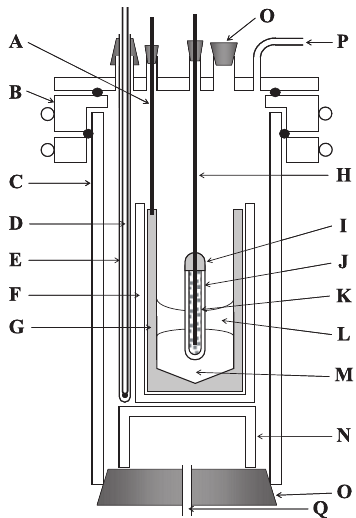
Fig. 1: Schematic diagram of the experimental apparatus. (A) iron rod, (B) water-cooled brass flange, (C) mullite reaction tube, (D) Pt-PtRh13 thermocouple, (E) alumina sheath, (F) alumina crucible, (G) iron crucible, (H) molybdenum rod, (I) zirconia cement, (J) ZrO (MgO) solid electrolyte tube, (K) Mo + MoO 2 electrode, (L) slag, (M) liquid silver, (N) alumina pedestal, (O) rubber stopper, (P) gas outlet, (Q) gas inlet.